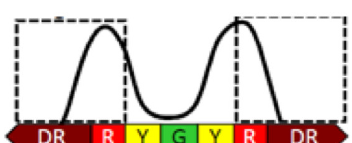
Figure 1. BI-MODAL distribution of inventory (Ptak & Smith, 2016)